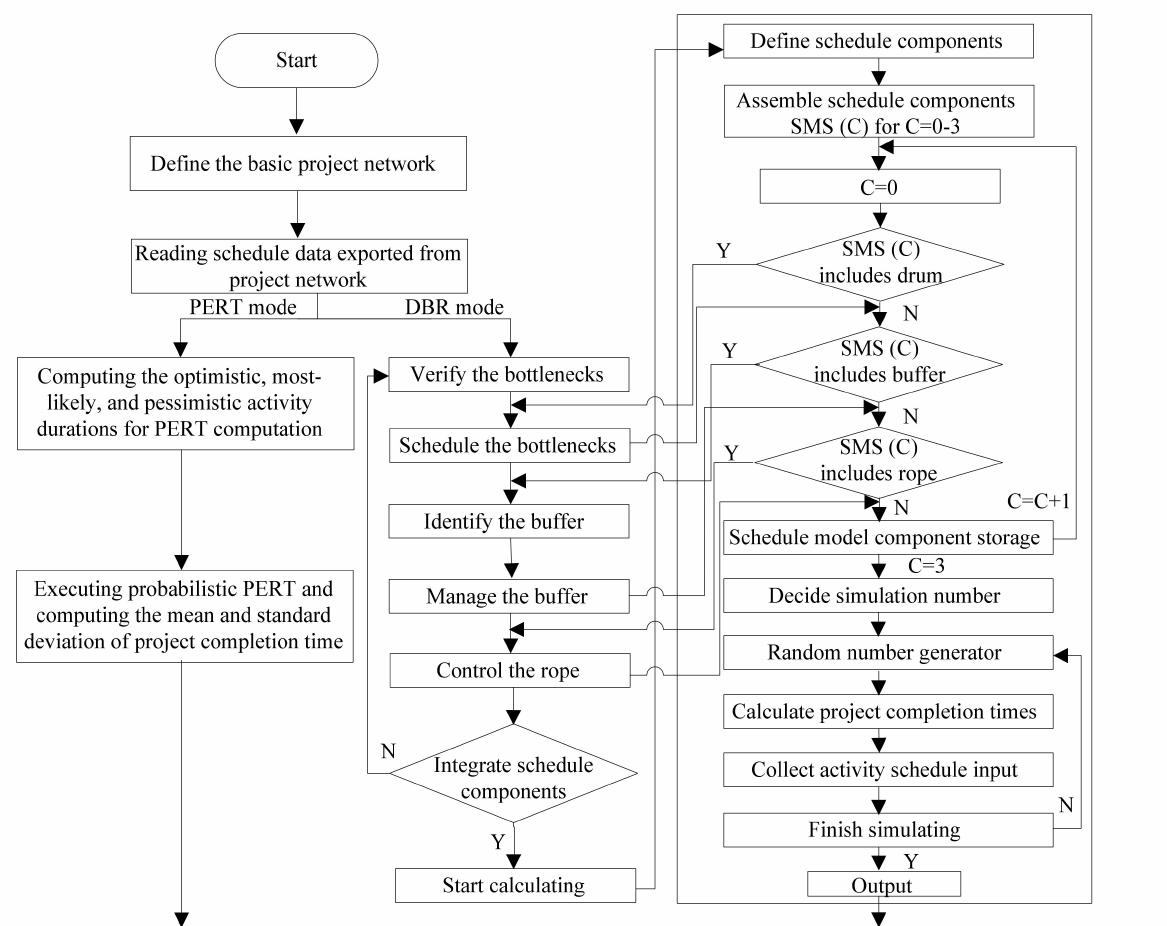
Figure 2. Flowchart of DBR model applied in construction project